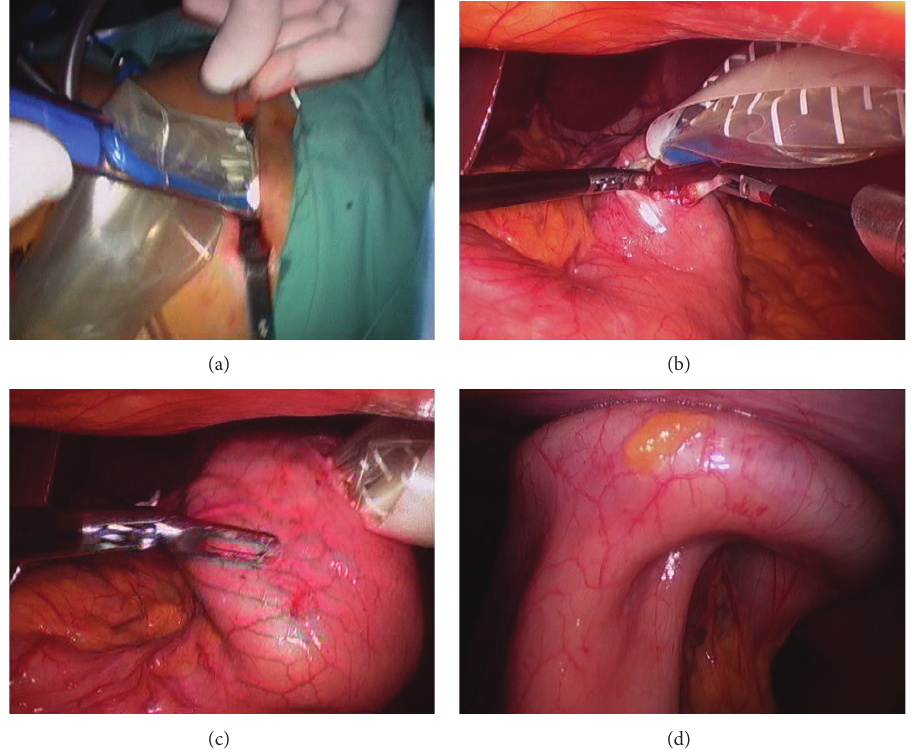
Figure 1: (a) Introduction of TriPort through abdominal wall. (b) Introducer is passed through gastrotomy. (c) Retraction of the device rising gastric wall up to abdominal wall. (d) TriPort fixed completely sealing both abdominal and gastric